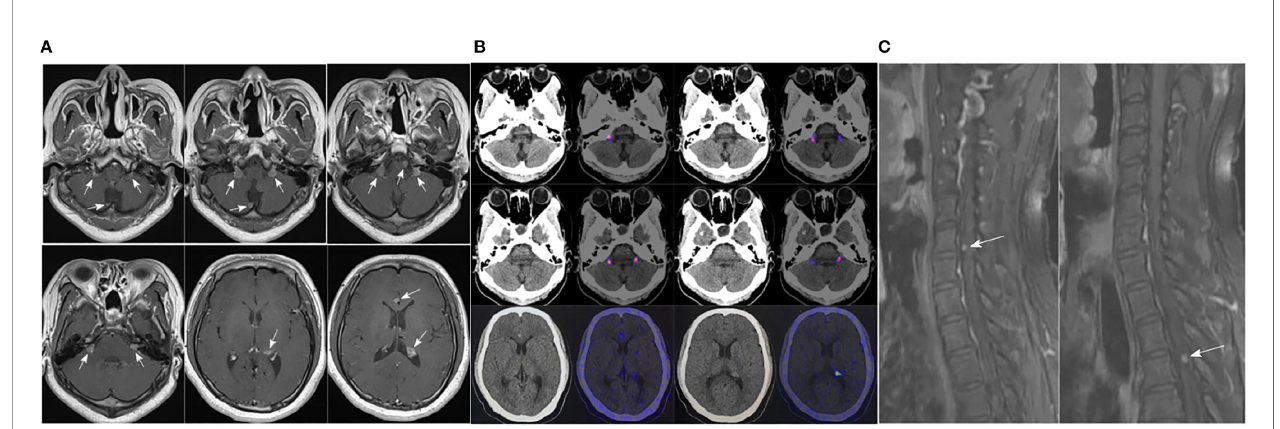
FIGURE 2 | (A) Pituitary enhanced MRI in October 2020 indicated: multiple enhanced nodules appeared in bilateral auditory nerve area, pons, medulla oblongata and near cerebral falx; (B) 68Ga DOTA-TATE PET-CT in March 2021 showed: no abnormal increase in 68Ga DOTA-TATE uptake was seen in the low-density shadow in the sella turcica; 68Ga DOTA-TATE uptakes in multiple soft tissue nodules in the brain (obvious in the bilateral jugular foramen area, corpus callosum knee, left ventricular triangle, etc.) increased; (C) Before the patient underwent whole-brain radiotherapy, a spinal cord enhanced MRI was completed, which revealed abnormal enhanced nodules in the sixth cervical vertebrae and fourth thoracic vertebral plane of the spinal